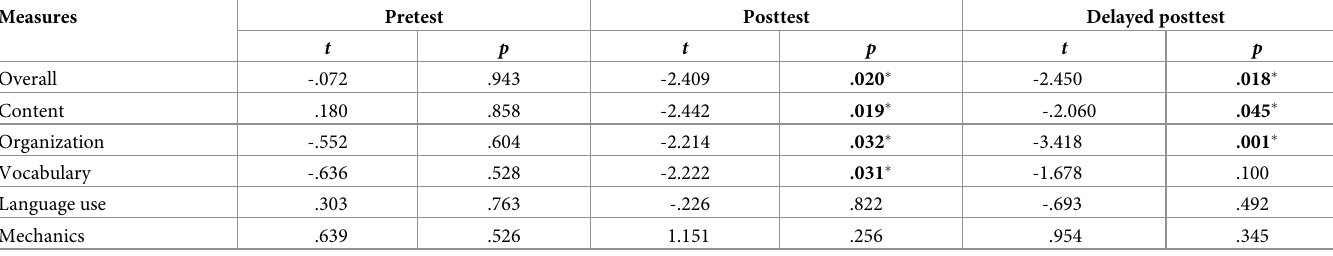
Table 3. Between-subjects comparisons of holistic and analytic scores of overall writing quality across